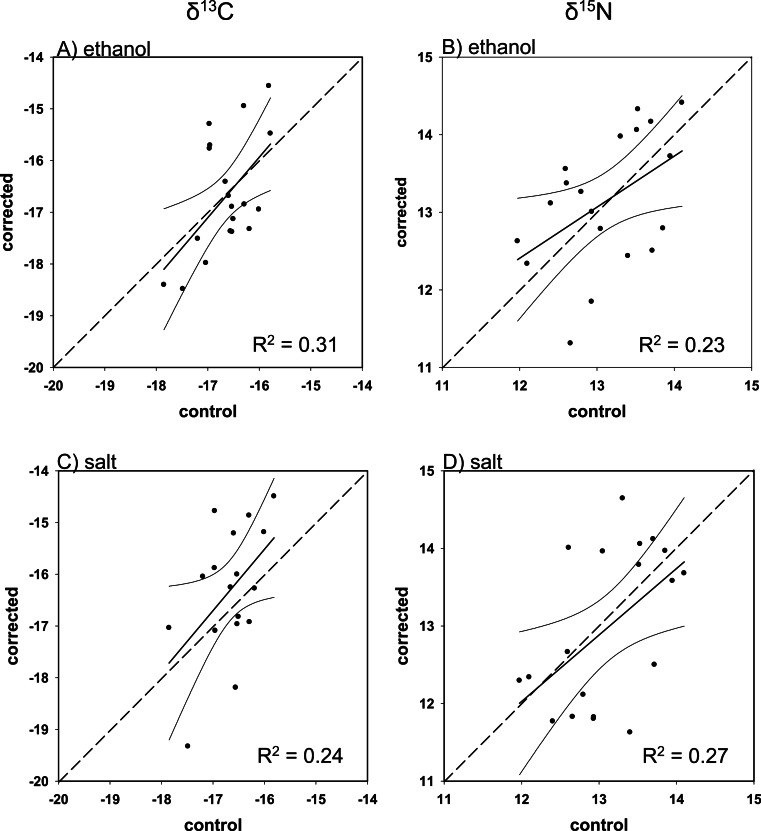
Mass balance corrected values against control values for M. microlepis.The 1:1 line (hashed), predicted (solid), and 95% confidence intervals are given for (A) ethanol δ13C, (B) ethanol δ15N, (C) salt δ13C, and (D) salt δ15N.